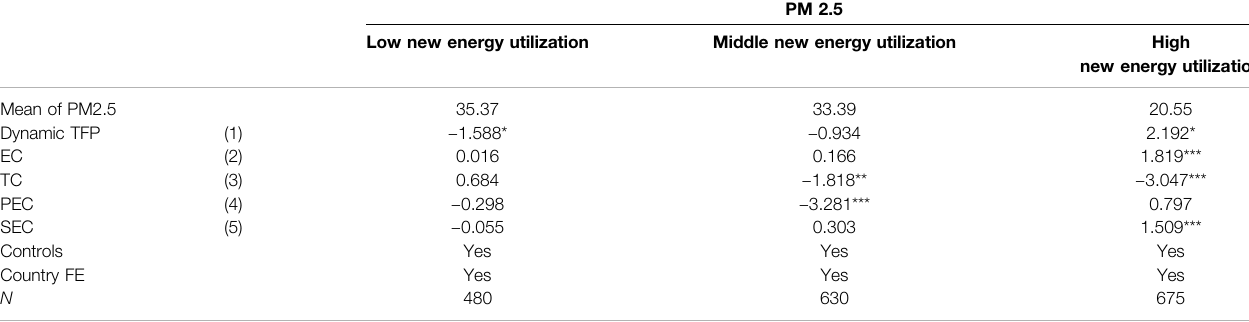
TABLE 10 | The estimation results for heterogeneity of new energy utilization.